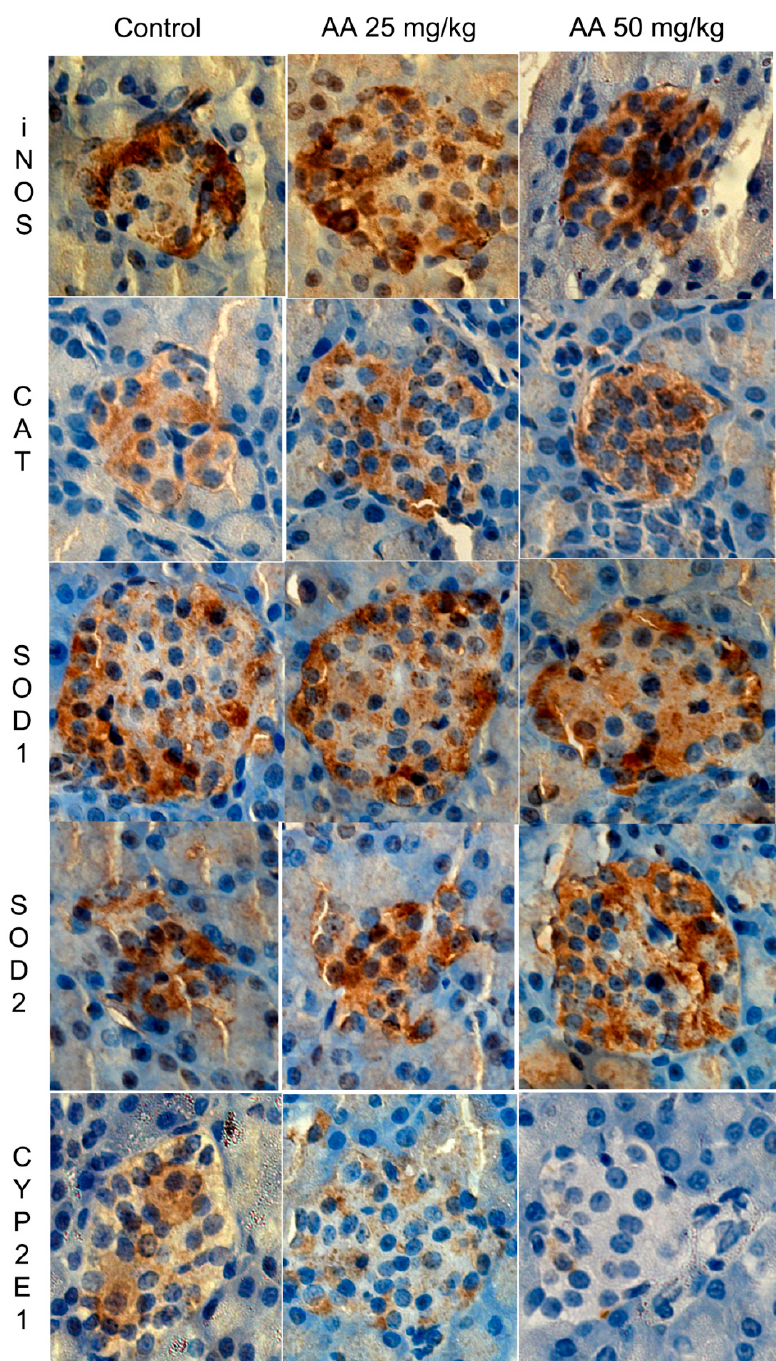
Figure 4. iNOS, CAT, SOD1, SOD2 and CYP2E1 immunohistochemically stained pancreatic islets of control and AA-treated rats. Male Wistar rats were treated with AA in doses of 25 mg/kg b.w./d and 50 mg/kg b.w./d; iNOS, inducible nitric oxide synthase; CAT, catalase; SOD, superoxide dismutase; CYP2E1, cytochrome P450 2E1; 400 × light microscope magnification